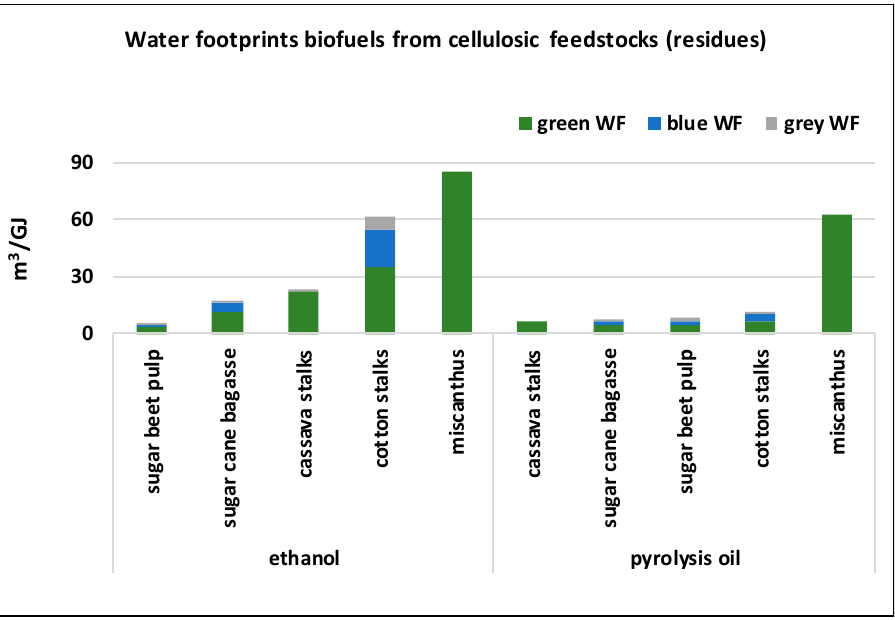
Figure 2. WFs for ethanol and pyrolysis oil from some cellulosic feedstocks, including crop residues and Miscanthus (source: Mathioudakis et al. [12]).